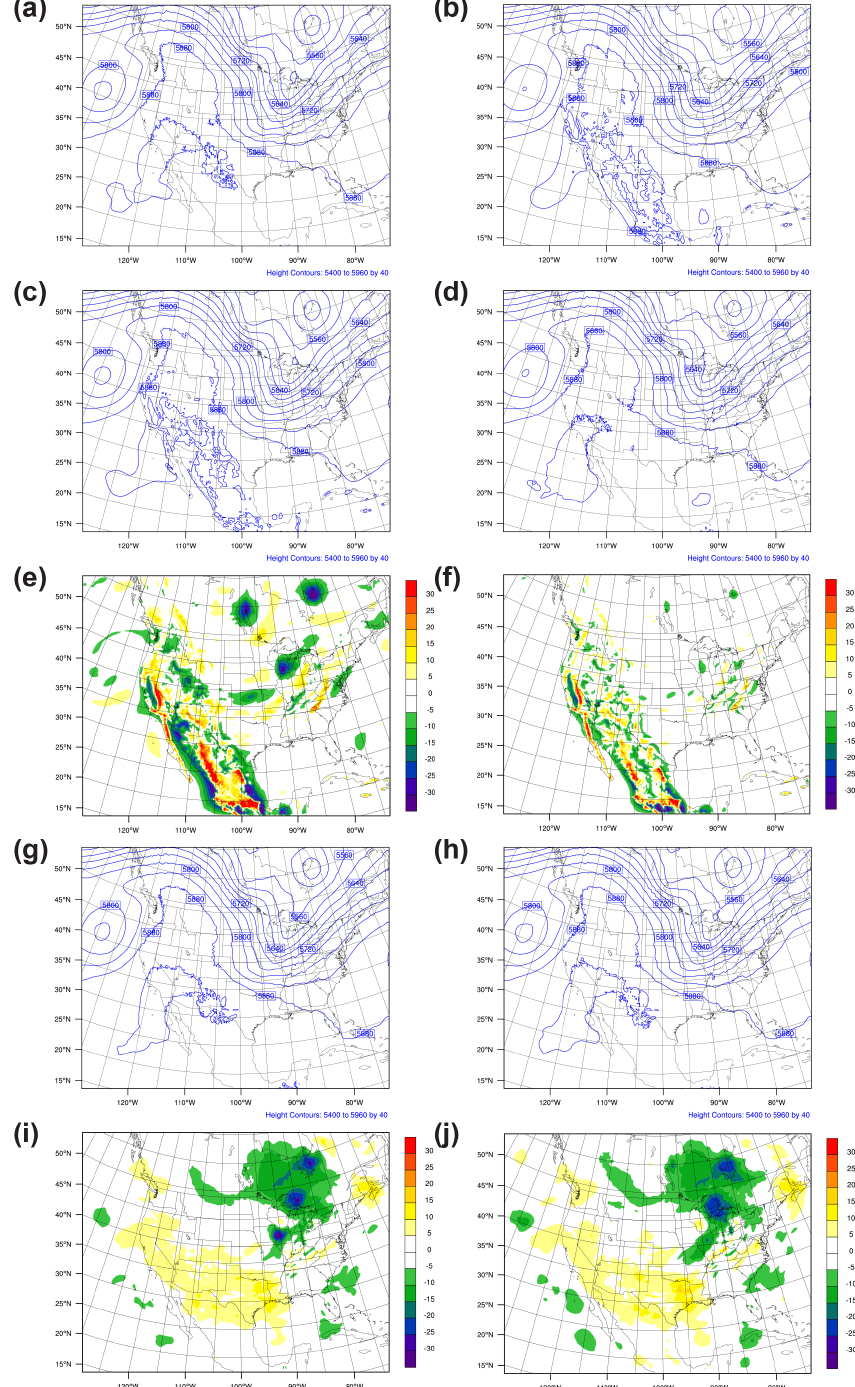
Figure 2. 500hPa geopotential height at 06:00UTC on 8 September 2012. (a) GFS 6h forecast, its filtered field with cut-off length scale (b) 1200km, (c) 600km; (d) WRF 6h forecast, differences from its filtered fields with cut-off length scale (e) 1200km, (f) 600km; blended fields with cut-off length scale (g) 1200km and (h) 600km; blended fields minus WRF 6h forecast with cut-off length scale (i) 1200km and (j)